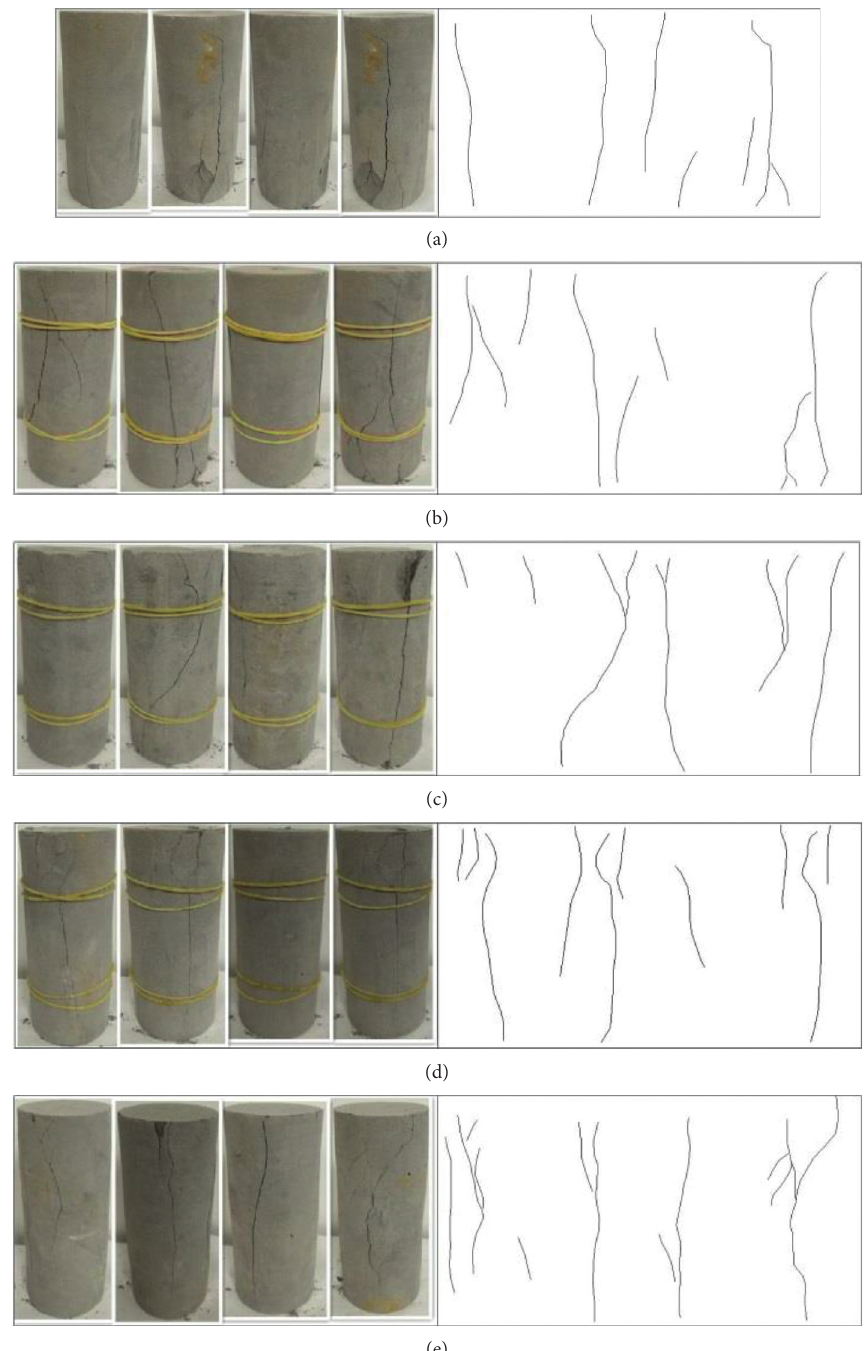
Figure 18: Failure mode of backfill samples under different water pressures. (a) 0 MPa water pressure. (b) 0.5MPa water pressure. (c) 1.0MPa water pressure. (d) 1.5MPa water pressure. (e) 2.0MPa water